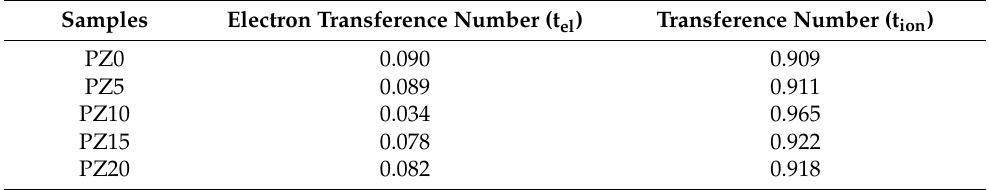
Table 5. Transference number of the PVA–CA–K 2 CO 3 /ZnO-NPs composite SPEs.